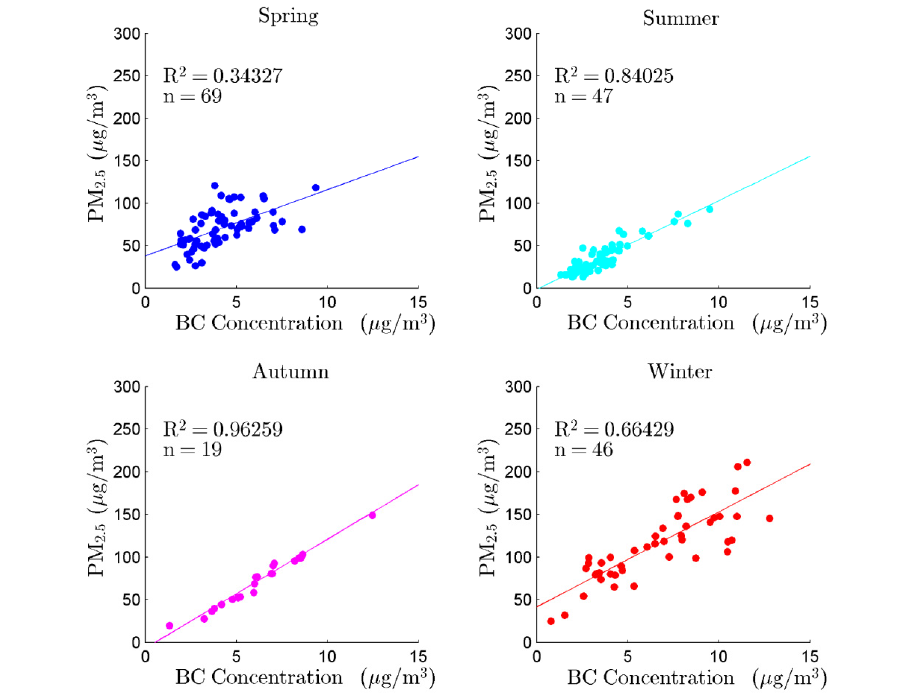
Figure 5. Correlation between the mass concentrations of PM 2.5 and black carbon (BC).